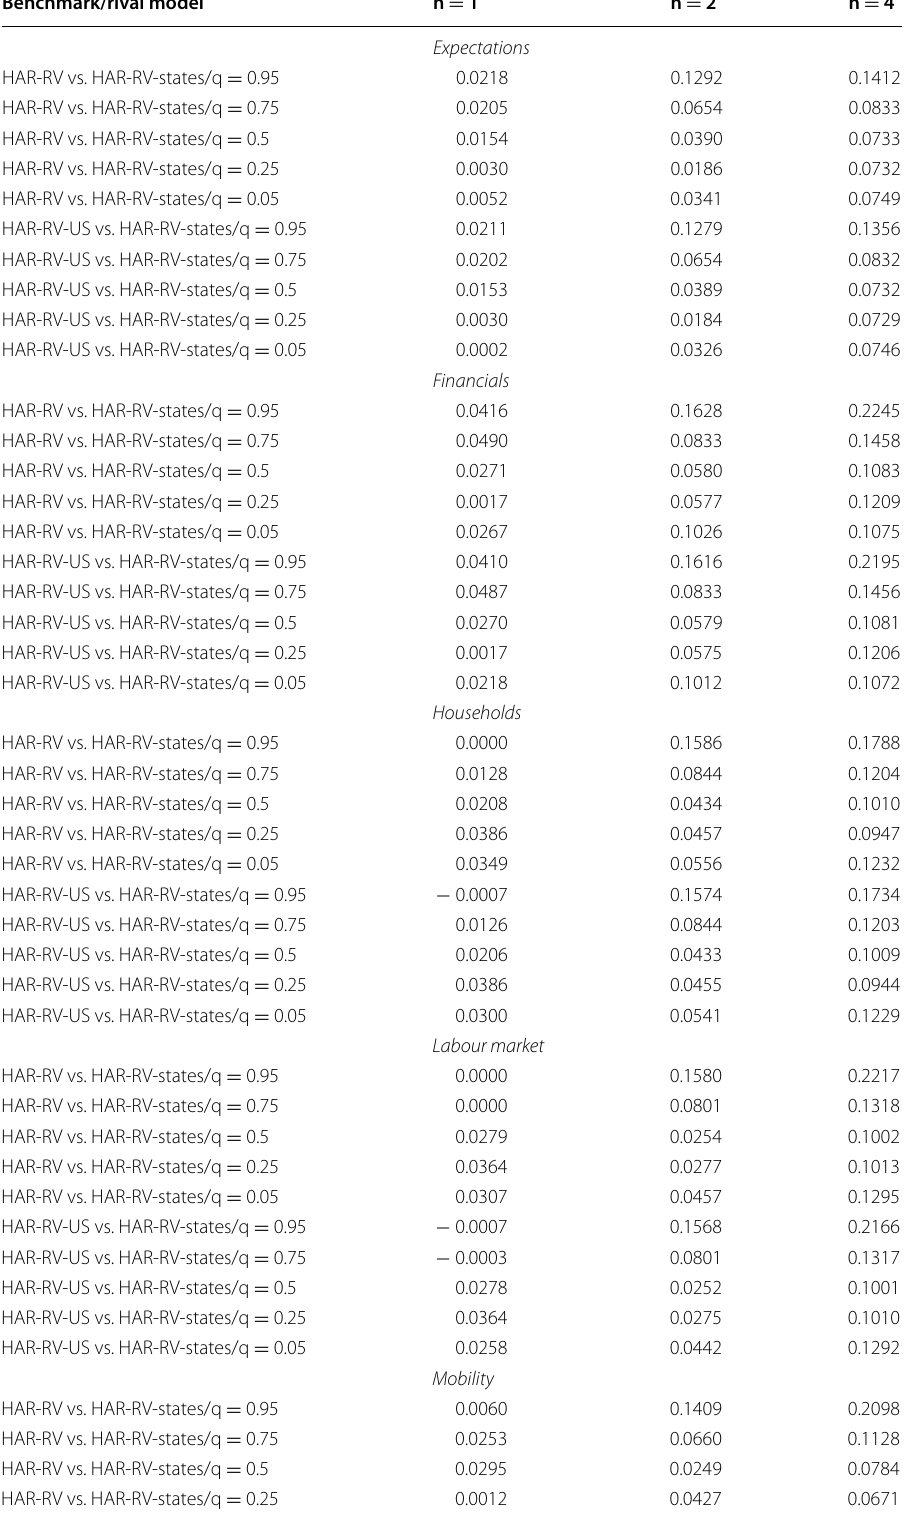
Table 5 Results for components of state-level economic conditions Benchmark/rival model h